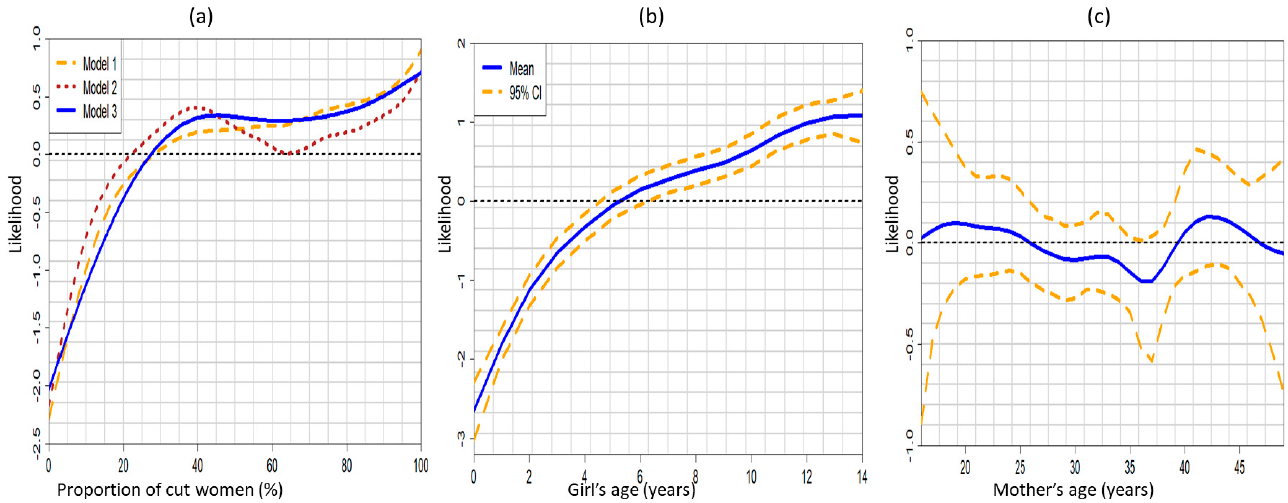
Figure 3. Non-linear effects of ( a ) the proportion of cut women in the community for the three models, ( b ) girl’s age, and ( c ) mother’s age, on a girl’s likelihood of experiencing FGM/C. Evidence from the 2017 SDHS (Model 3).